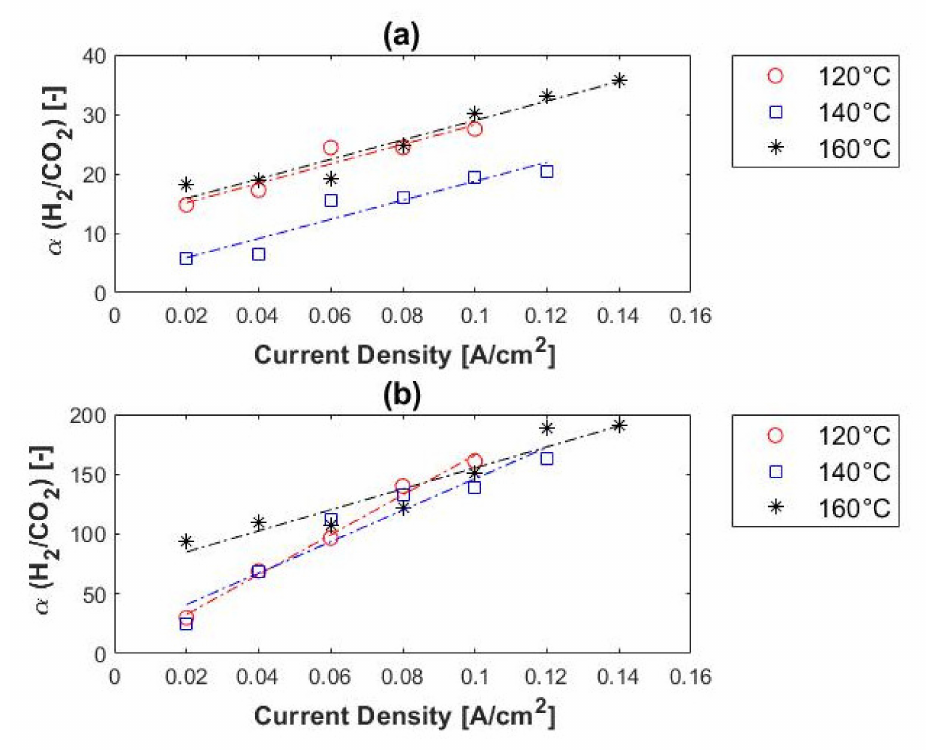
Figure 12. H 2 /CO 2 selectivity, in terms of carbon dioxide concentration, versus current density: ( a ) 10% and ( b ) 50% carbon dioxide, balance hydrogen (hydrogen flow rate = 100 mL n /min, 1